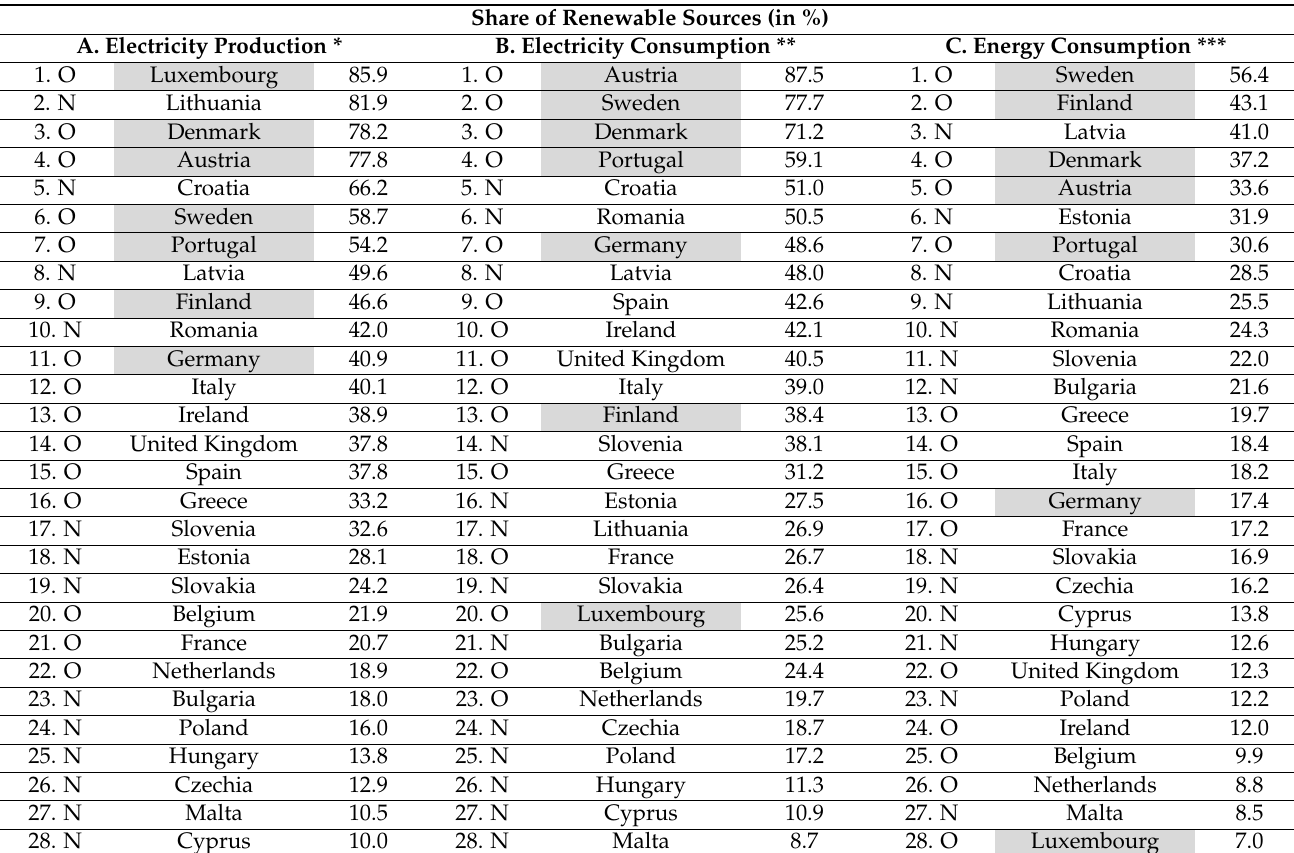
Table 3. Share of renewable sources in electricity production and consumption and total energy consumption (in %) in European Union countries—country rankings for